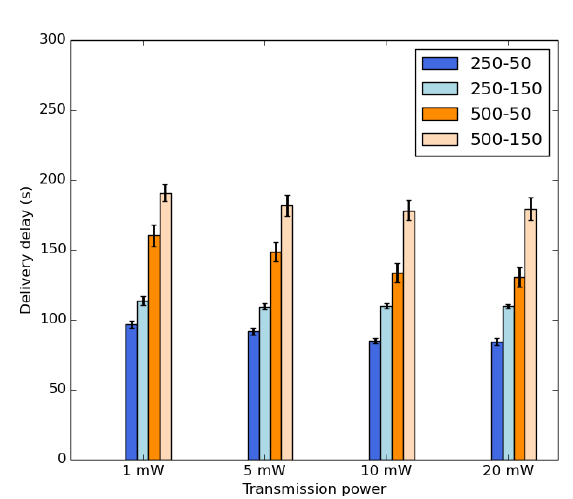
Figure 15. Average delivery